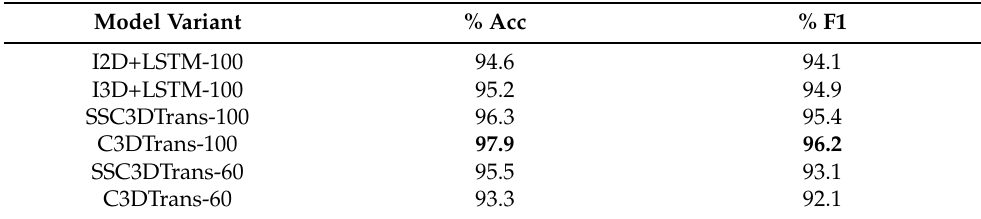
Table 7. Gesture-level results of the KT task. The best results column-wise are shown in bold.